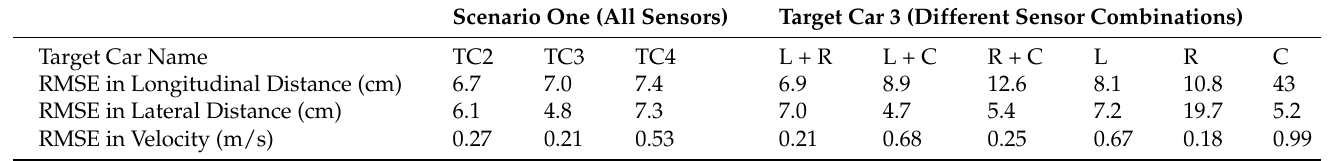
Table 1. The first group of columns is the result of the fusion for each individual car when all the sensors were in use. The second group of columns is the result of the fusion when employing different combinations in the sensor set for Target Car 3. The root mean square error (RMSE) values for both scenarios and every tracked object are shown, where the RMSE is the standard deviation of the residuals (prediction error). Here, cm = centimeter, m/s: meters per second, L = LiDAR, R = radar, C = camera, L+R = LiDAR and Radar used at same time,